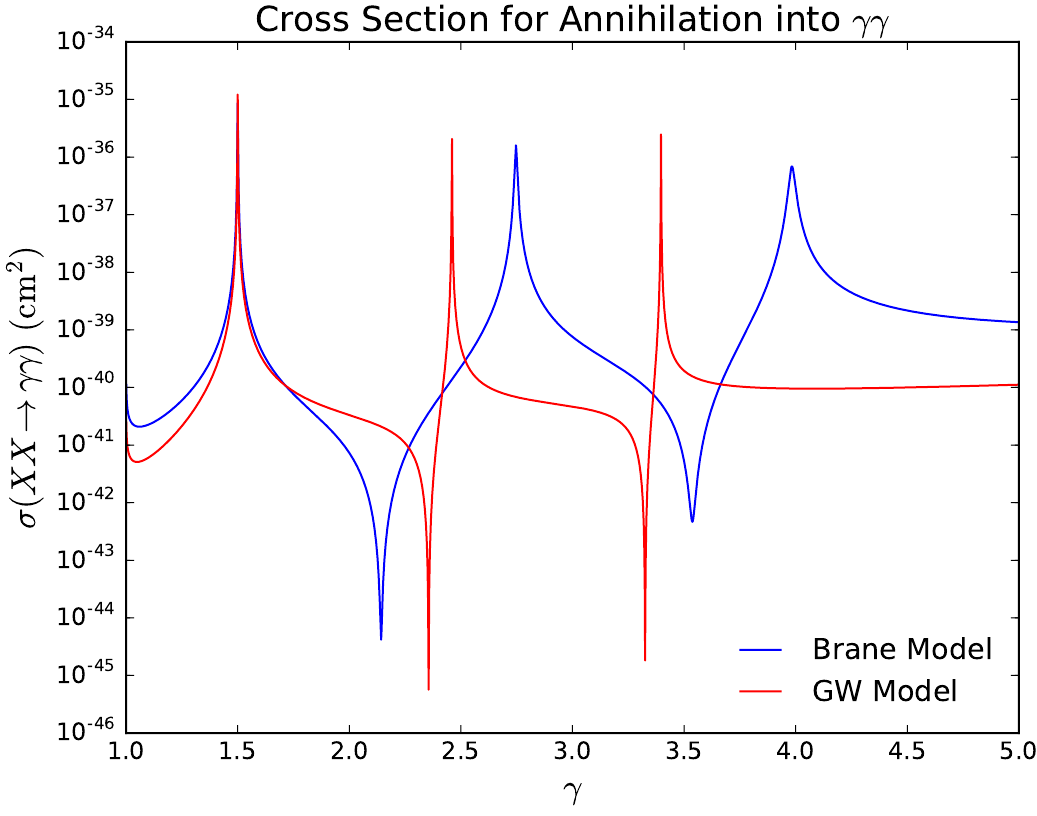
Figure 3 . The cross section for spin-1 dark matter annihilating through s -channel exchange of the p (cid:12)rst 3 KK gravitons as a function of the Lorentz factor (cid:13) = s= 2 m X for the GW (red) and Brane (blue) models, taking m X = 1000 GeV and m G = 3000 GeV. Note in particular that the weaker 1 couplings of the higher KK gravitons to matter in the GW model push the maximal interference conditions close to the s -channel resonance